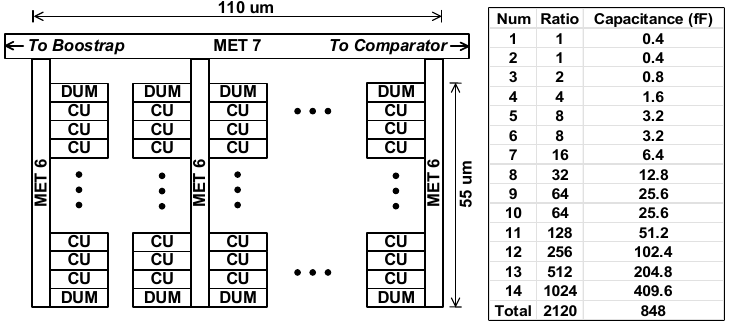
Figure 13. The layout of the CDAC with the CRD using MOS capacitors.